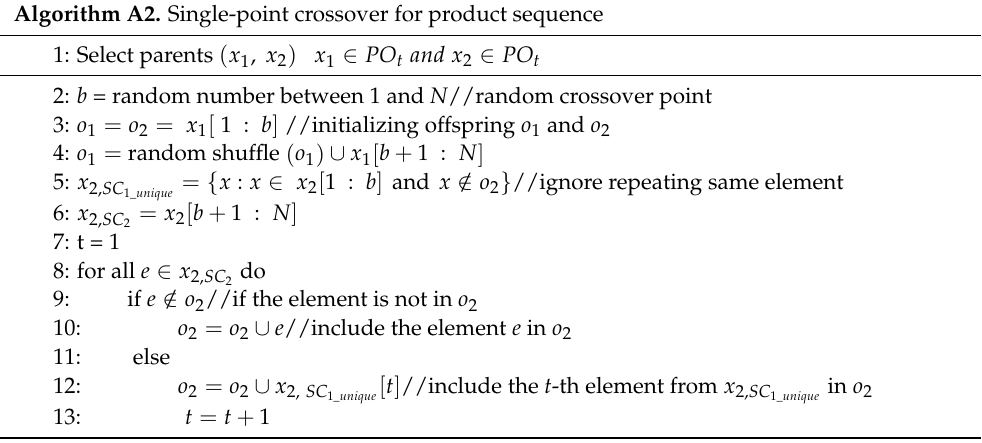
Algorithm A2. Single-point crossover for product